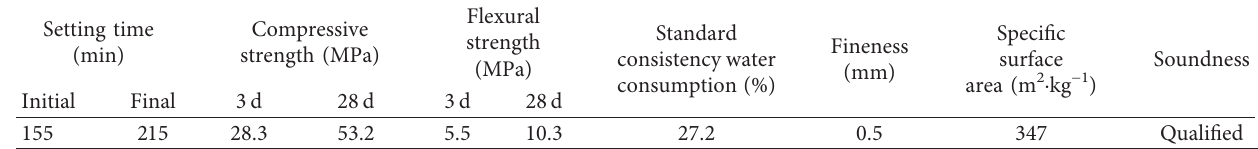
Table 1: Main properties of reference cement.